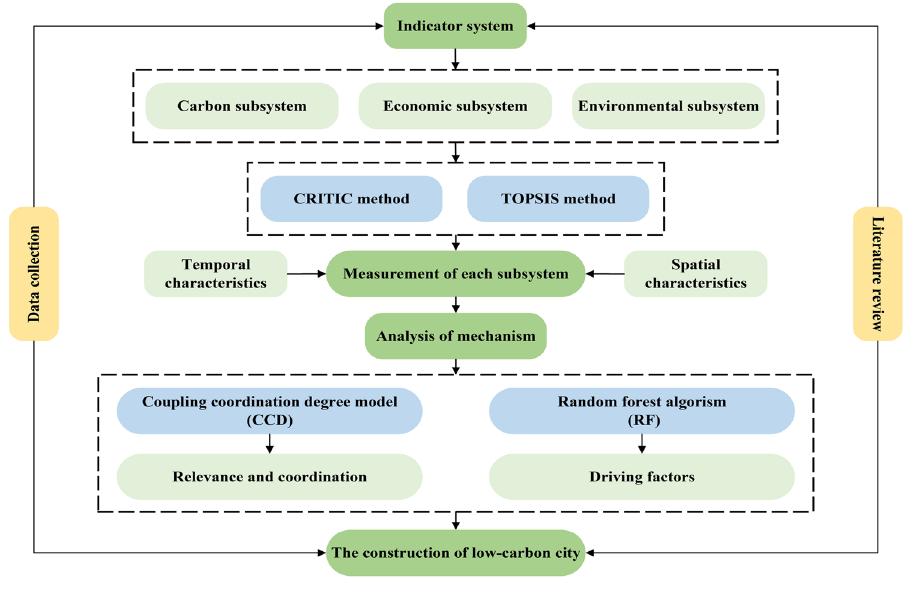
Figure 1. Research